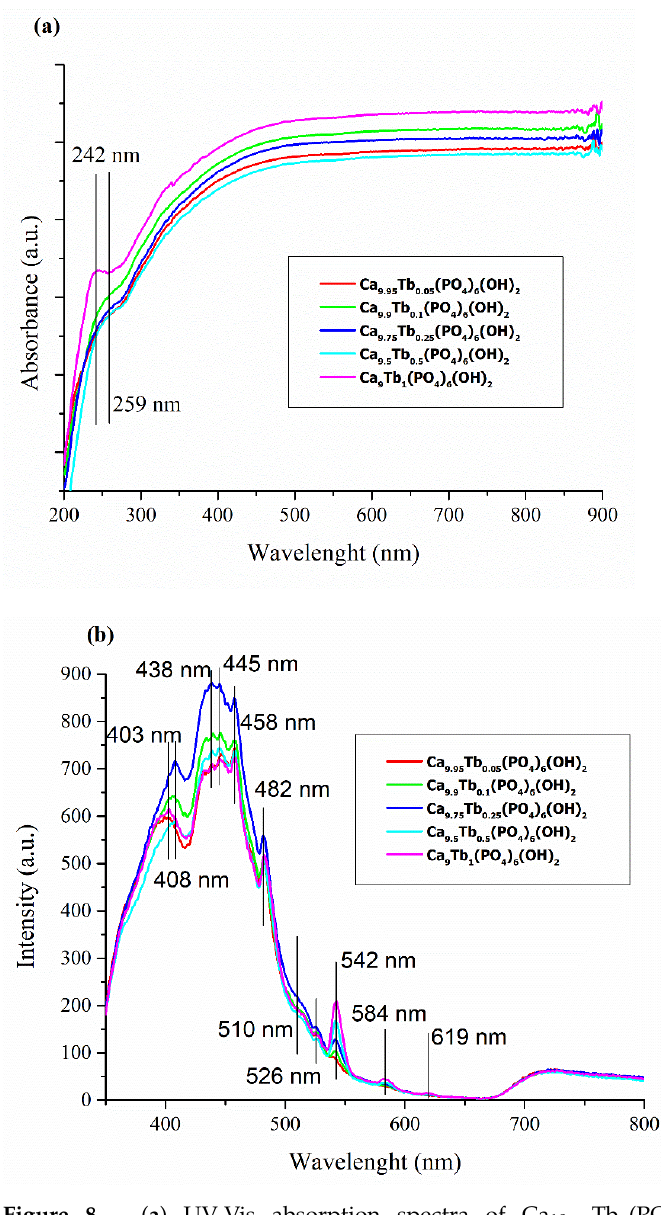
Figure 8. ( a ) UV-Vis absorption spectra of Ca 10 − x Tb x (PO 4 ) 6 (OH) 2 ; ( b ) PL spectra of Ca 10 − x Tb x (PO 4 ) 6 (OH)2. The PL emission spectra of Ca 10 − x Tb x (PO 4 ) 6 (OH) 2 at different concentrations from Fig-